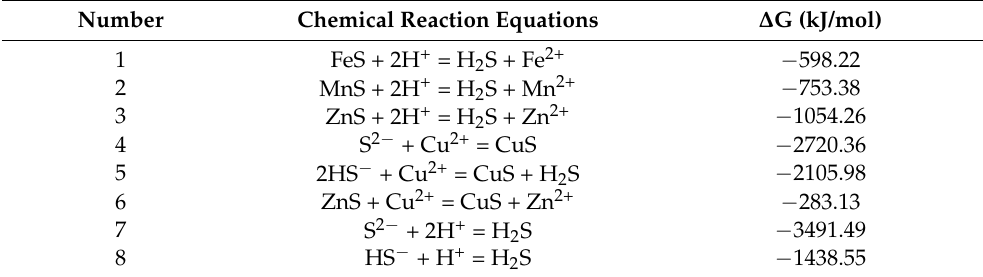
Table 2. The possible chemical reaction equations and corresponding calculation results of ∆ G in the copper precipitation